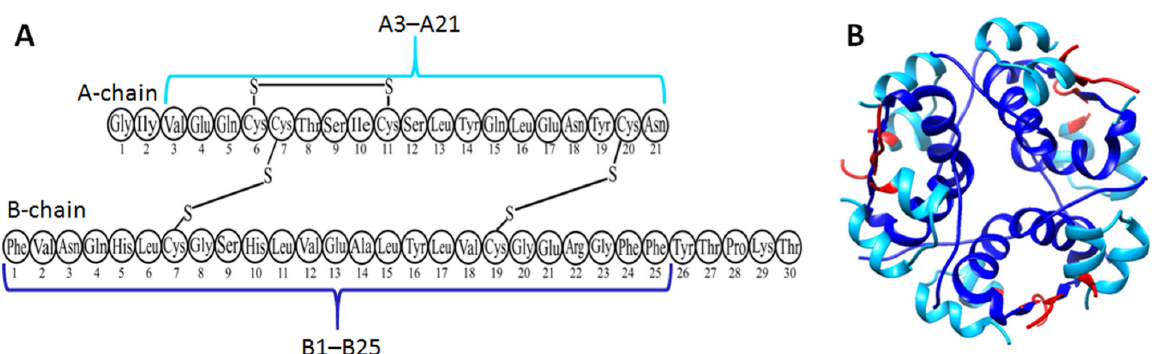
Figure 10. Results of proteolysis of insulin fibrils for amino acid sequences ( A ) and for 3D structure ( B ). PDB file 5e7w was used. Two fragments A3–A21 and B1–B25 are protected (inside the fibrils) from the action of proteases—trypsin, chymotrypsin, and proteinase K. In ( B ), residues accessible to proteases are colored